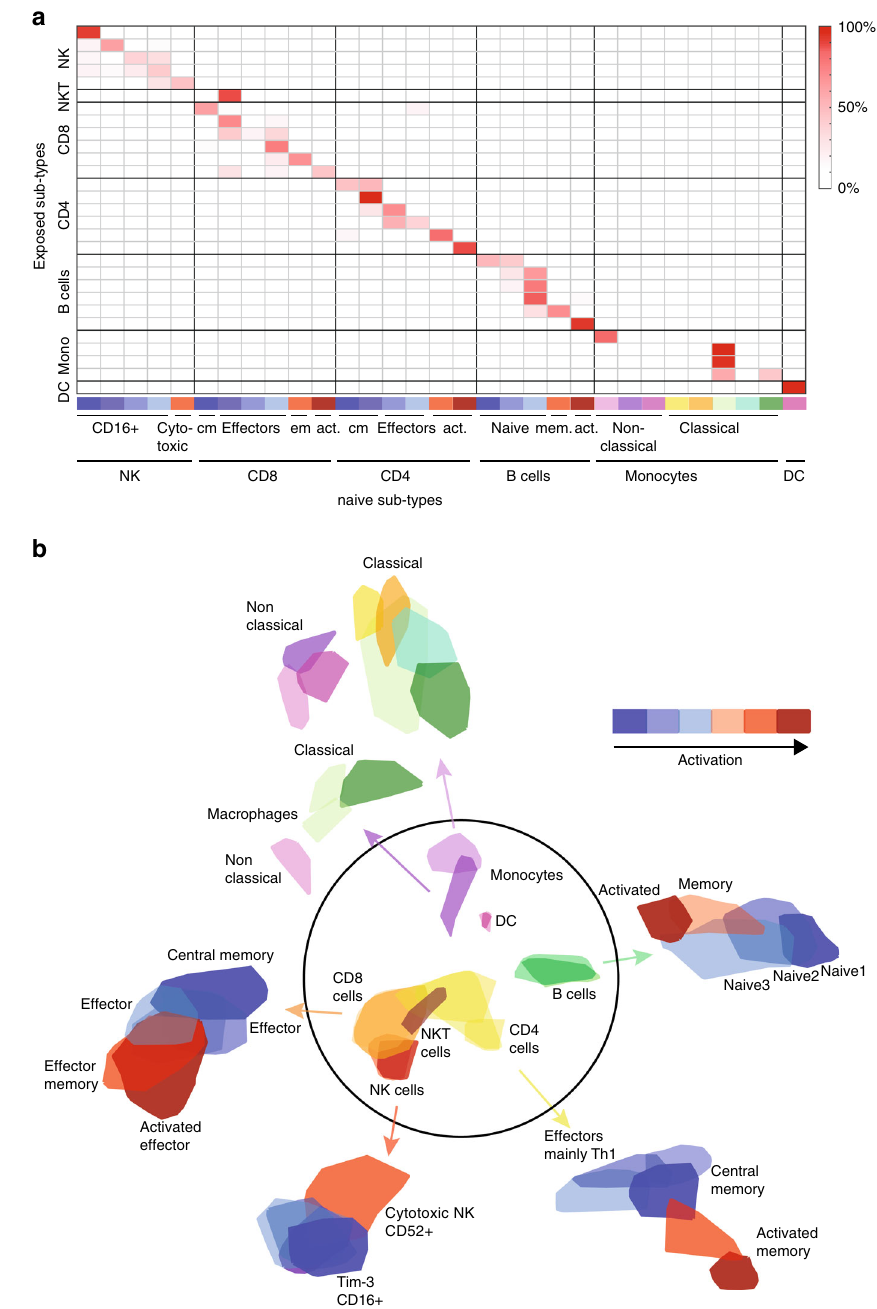
Fig. 2 Characterization of human PBMCs intrinsic sub-types before and after Salmonella infection. a Classi fi cation of exposed cells inferred from the cell sub-types of the naive cells using KNN-classi fi cation. The connectivity matrix entries are the calculated percentage of cells from each sub-type of the exposed sample ( y -axis) that were classi fi ed to each sub-type of the naive sample ( x -axis) (see colorbar to the right corresponding to the matrix entries). Cell sub-types identity was inferred from the differentially expressed genes that uniquely characterize each sub-type (Supplementary Fig. 7; color code of sub-types from blue to red represents activation state, found already at steady-state, regardless of the infection response). b Graph-based clustering revealed the repertoire of immune sub-types before and after infection (intrinsic fi ngerprints). The middle circle presents the contours of the cell types based on the KNN-graph from Fig. 1d, and for each cell type further partition into sub-types is shown. Contours are drawn for both the naive and exposed samples together as classi fi ed by the KNN-classi fi cation in a , without the infection genes (colorbar represents activation state from blue to red, which exists already at steady-state, regardless of the infection response). The monocytes were colored based on the different sub-types before and after infection to allow association between the exposed sub-types to the naive sub-types (see also Supplementary Fig. 7 for visualization of the naive and exposed cells relative to the contours and the differentially expressed genes which de fi nes each